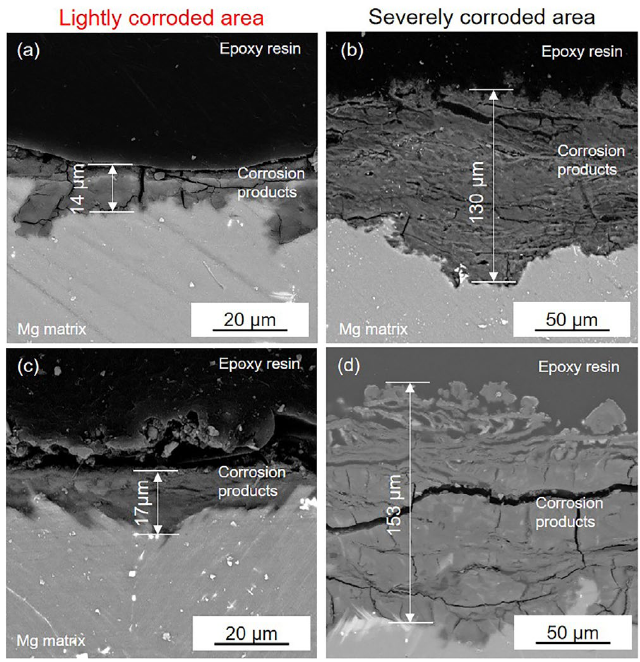
Figure 8. SEM images of the cross-section of ( a , b ) the black area on the HOMO samples and ( c , d ) the black area on the LPSO samples after 24 h immersion.